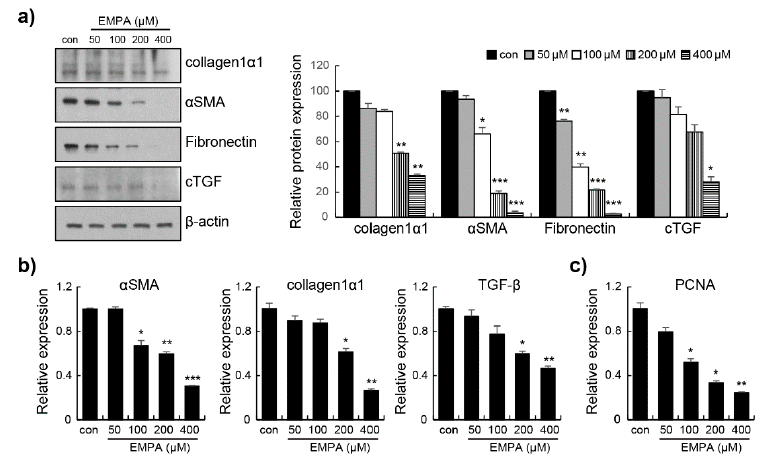
Figure 2. Empagliflozin downregulates pro-fibrogenic markers and decreases proliferation in LX-2 cells. ( a ) Collagen 1 α 1, α -SMA, fibronectin, and cTGF were assayed by Western blotting using specific antibodies. The maximum control phosphoprotein intensity was set to 100%, and relative test intensities were calculated. ( b ) The relative expression of α -SMA , Collagen 1 α 1, and TGF- β was determined via real-time polymerase chain reaction (RT-PCR). ( c ) The cell proliferation marker, proliferating cell nuclear antigen ( PCNA ), was determined via RT-PCR. Data are expressed as means ± standard deviation of three independent experiments. * p < 0.05, ** p < 0.01, and *** p < 0.001 compared to the control.